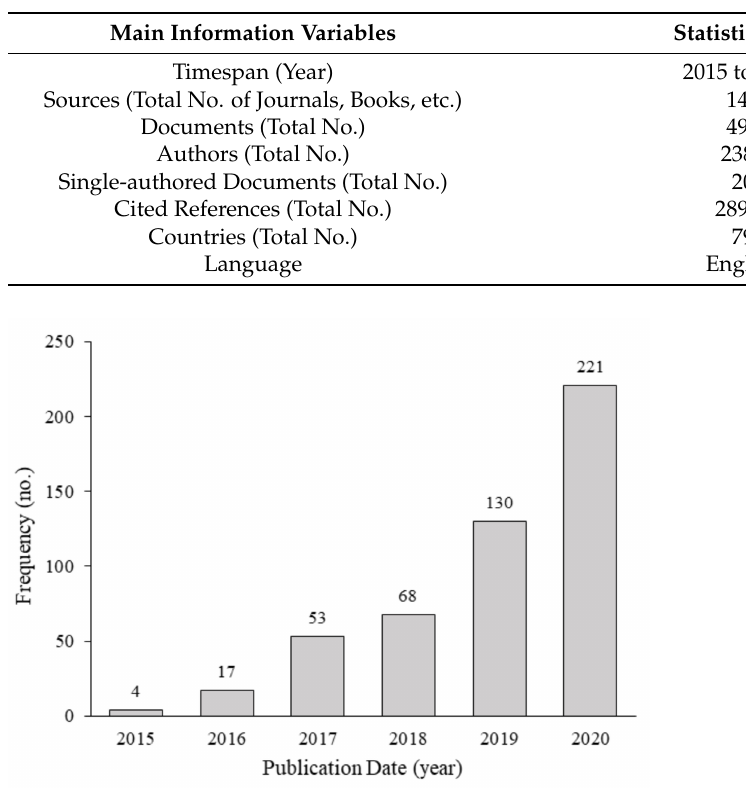
Table 2. Main information of NBS publications from the Web of Science between 2015 to 2020.